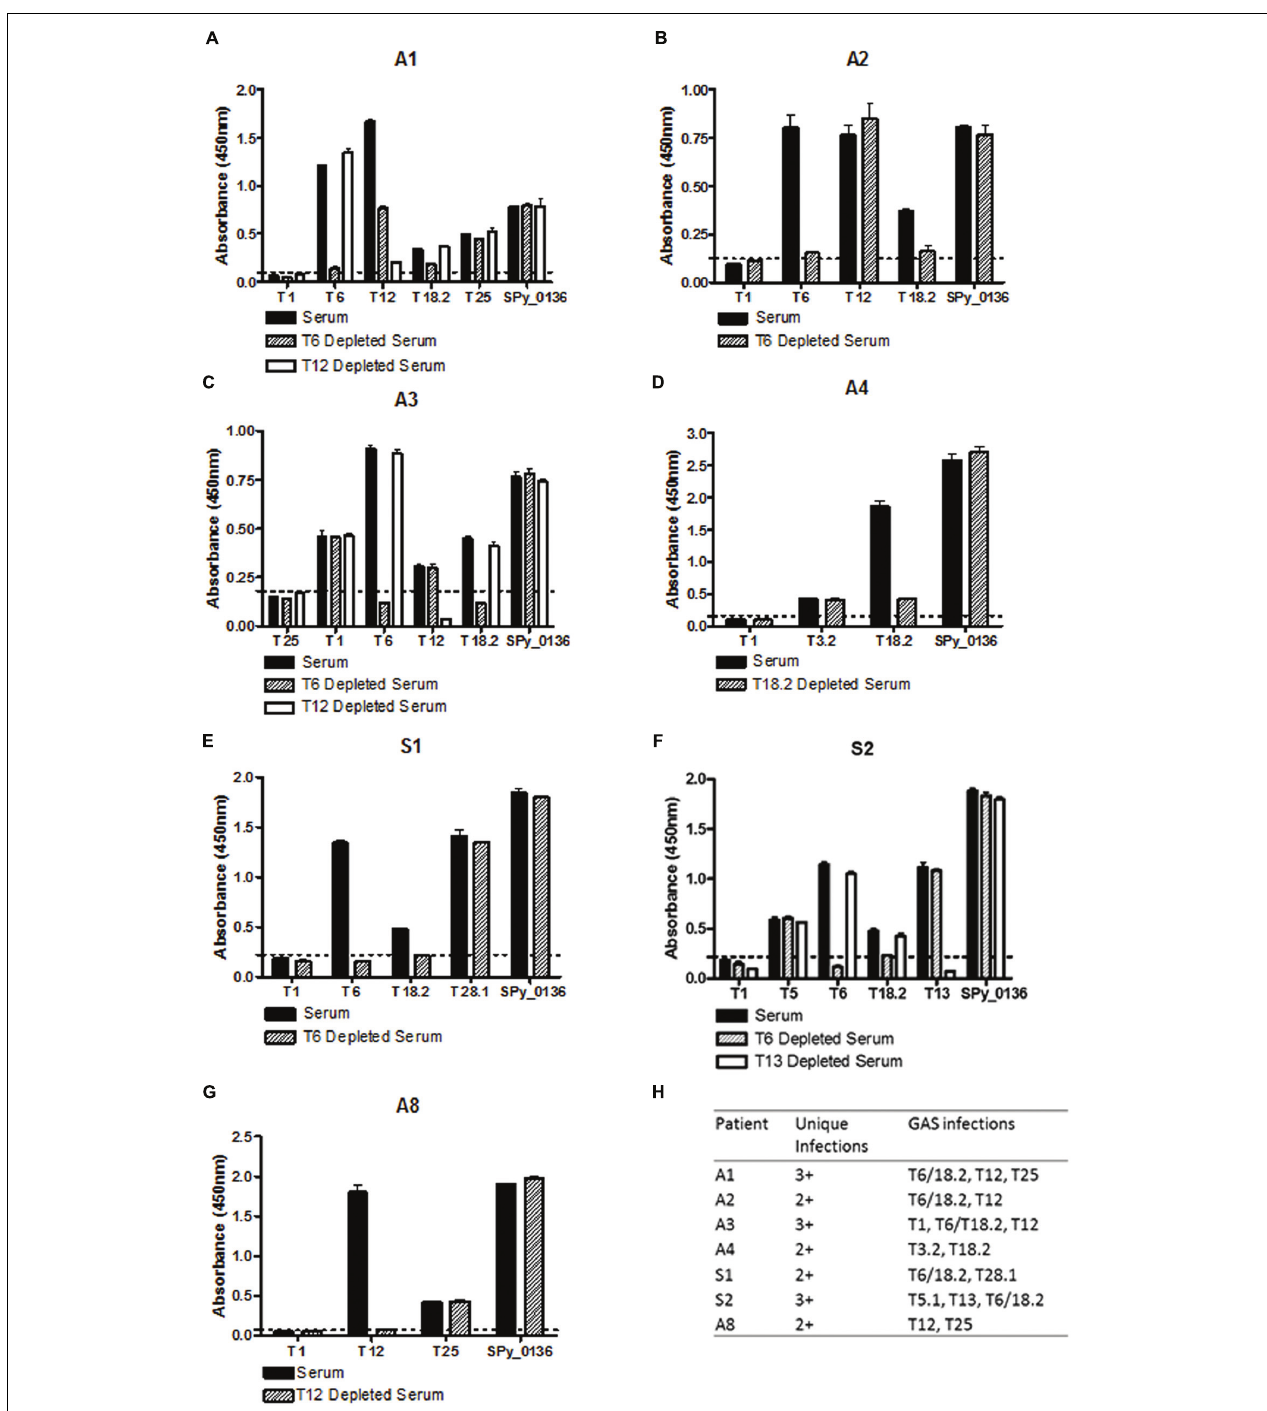
FIGURE 1 | Mapping Group A Streptococcus (GAS) infection history using a T-antigen array. Sera were obtained from seven patients diagnosed with first-episode Acute rheumatic fever (ARF). For depletion of T-antigen specific antibodies sera were diluted 1:100 in PBS pH 7.4 and passed over a T-antigen column. Unbound antibodies (depleted serum) were collected for analysis by ELISA. T-antigens (5 µ g/mL) were coated onto immunoplates, incubated with patient serum (1 h at 37 ◦ C) and total IgG binding detected. Reactivity of un-depleted serum (solid bars) and depleted serum (crosshatched and white bars) for each participant is shown in A–G , and a summary of the data is shown in H . All depletion ELISAs included a non-reactive T-antigen as a negative control and the conserved GAS protein Spy_0136 (NP_268523) as a non-T-antigen positive control. Samples were considered to have a specific T-antigen antibody response if the absorbance values were at least two standard deviations higher than the mean of the negative control (dotted line). The depletion process did not affect serum reactivity with the positive control.